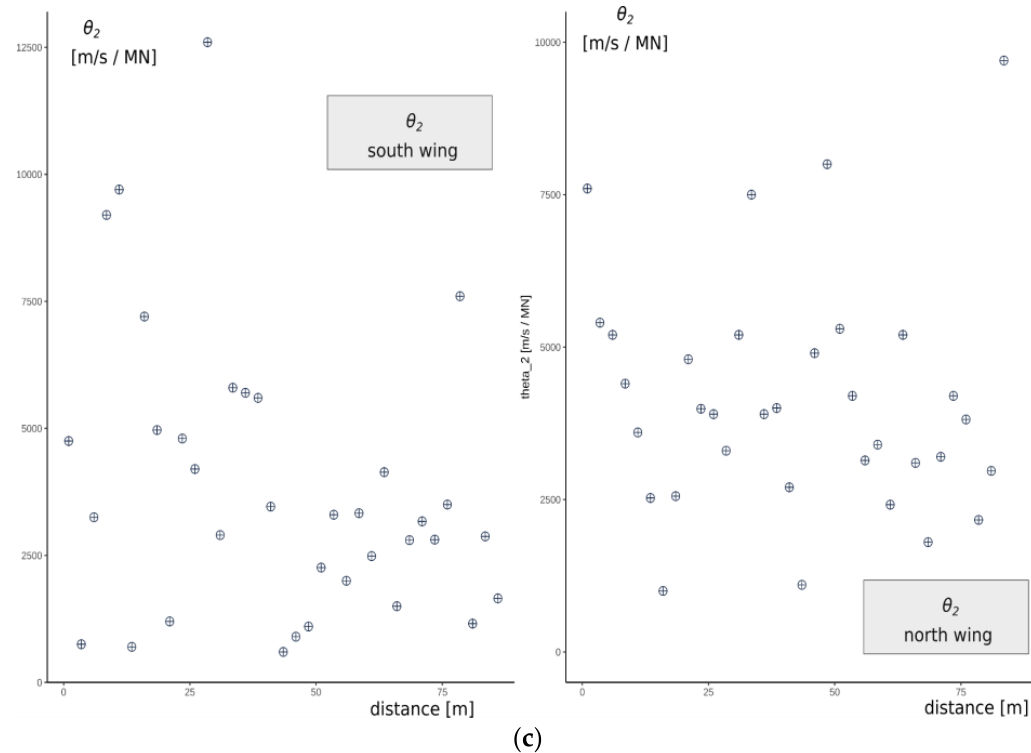
Figure 10. Values of ( a ) γ 1 , ( b ) γ 2 , ( c ) θ 2 plotted against anchor position for south and north wings. Table 1. Model parameters with their direct statistics. South Wing Parameter